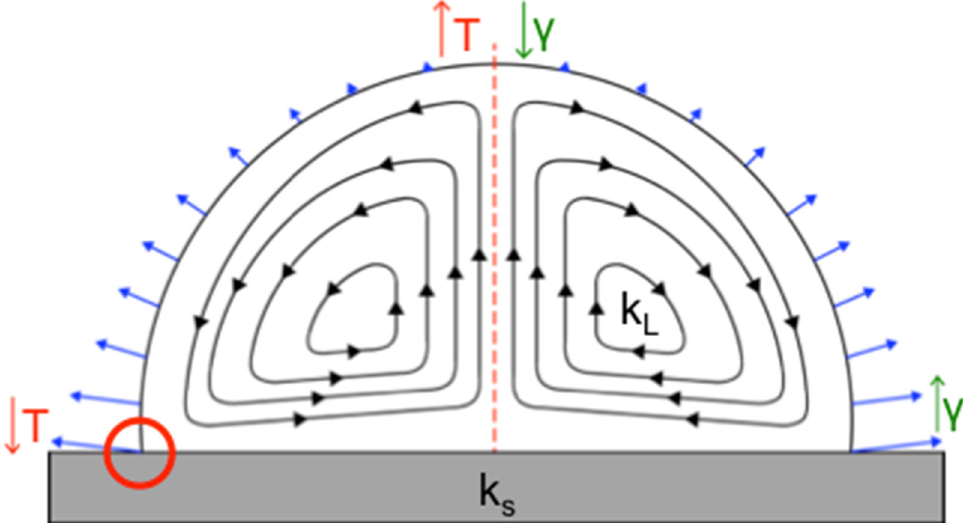
Figure 1. Physical phenomena that contribute to Marangoni flow formation and direction. Surface tension ( γ ) and thermal conductivity (k) of the surface (k s ) and droplet solvent (k L ) can be manipulated to create inward- or outward-oriented Marangoni flow patterns in an evaporating droplet. In this case, nonuniform evaporation along the liquid–air interface of the droplet (blue triangle arrows) occurs. This creates a temperature gradient (T) that results in a nonuniform surface tension gradient. When k s < 1.45k L , where the temperature at the top of the droplet is warmest, while the contact line is coldest (indicated by red circle), the microfluidic flows within the droplet circulate radially inward along the solid substrate (black triangle arrows) independent of surface tension [10,11] (Adapted from ref. [11]).